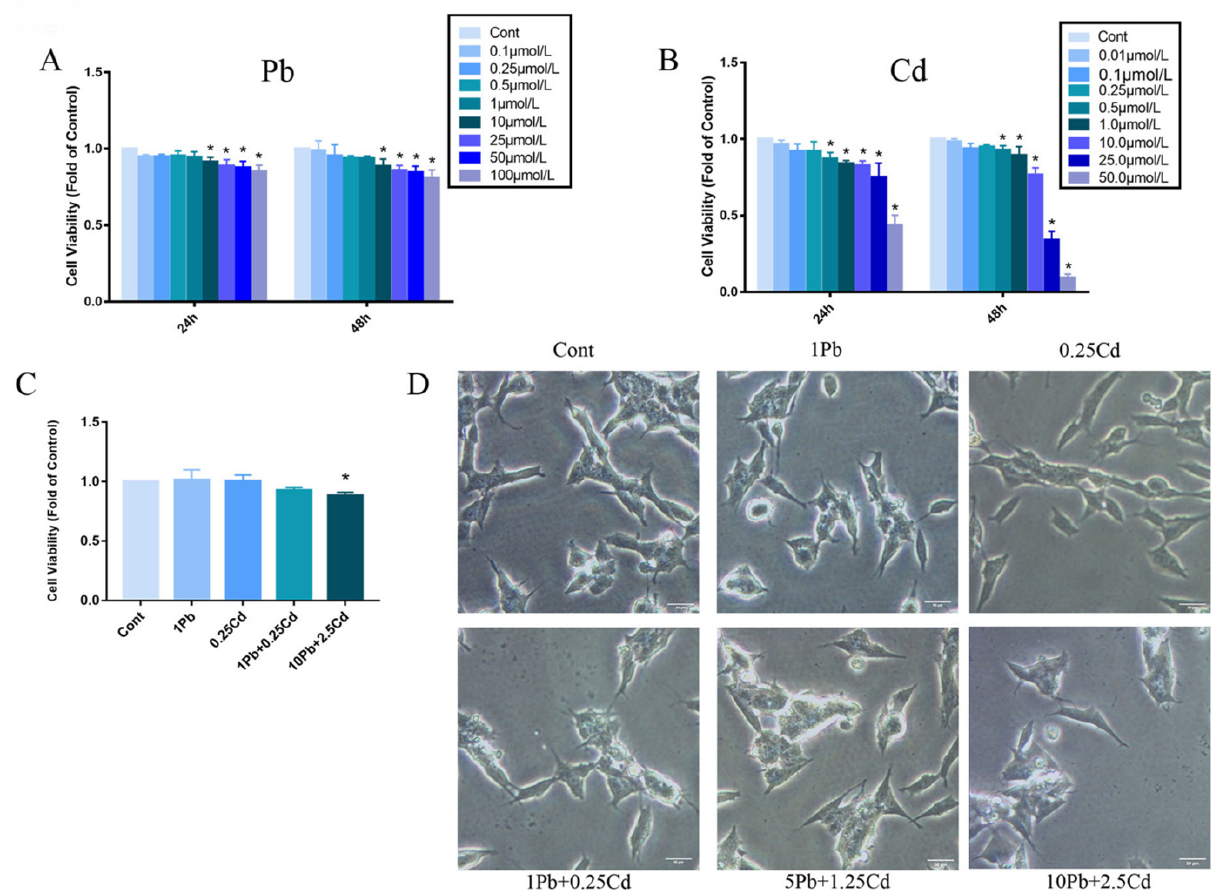
Figure 1. Survival rate of SH-SY5Y cells under different concentrations of Pb and Cd for 24 and 48 h. ( A , B ) SH-SY5Y cells were treated with Pb (0~100 μ mol/L) or Cd (0~50 μ mol/L) for 24 and 48 h. ( C ) Survival rate of SH-SY5Y cells under lead and cadmium co-exposure for 24 h. An amount of 1 Pb is 1 μ mol/L Pb, and 0.25 Cd is 0.25 μ mol/L Cd. An amount of 1 Pb + 0.25 Cd is the mixture of 1 μ mol/L Pb + 0.25 μ mol/L Cd; 10 Pb + 2.5 Cd is the mixture of 10 μ mol/L Pb + 2.5 μ mol/L Cd. ( D ) Morphological changes of SH-SY5Y cells were observed after co-exposure to Pb and Cd for 24 h. Scale bars: 50 μ m. *, p < 0.05 compared with the control, data are presented as mean ± SD.